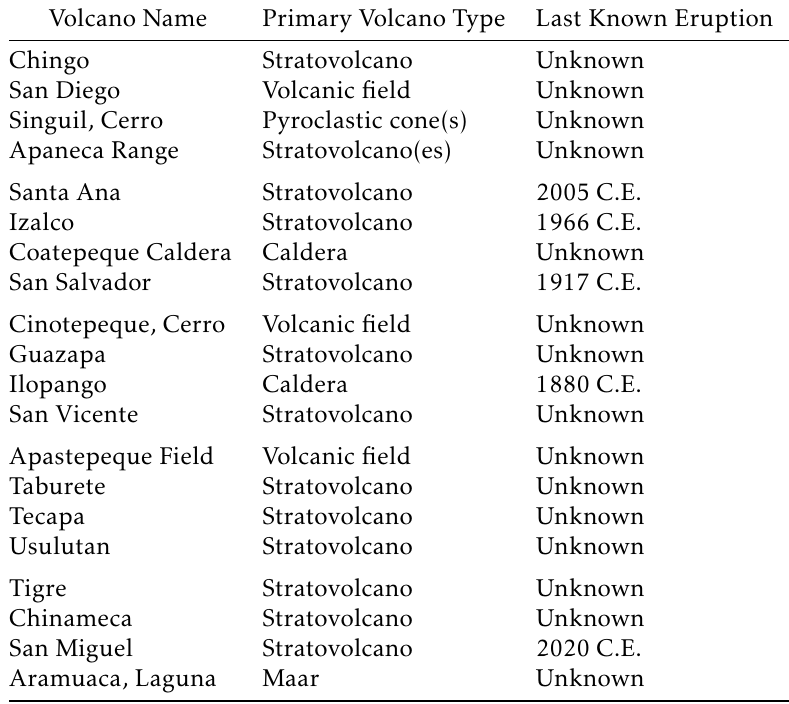
Table 1: Volcanoes in El Salvador that have been active throughout the Holocene [Global Volcanism Program